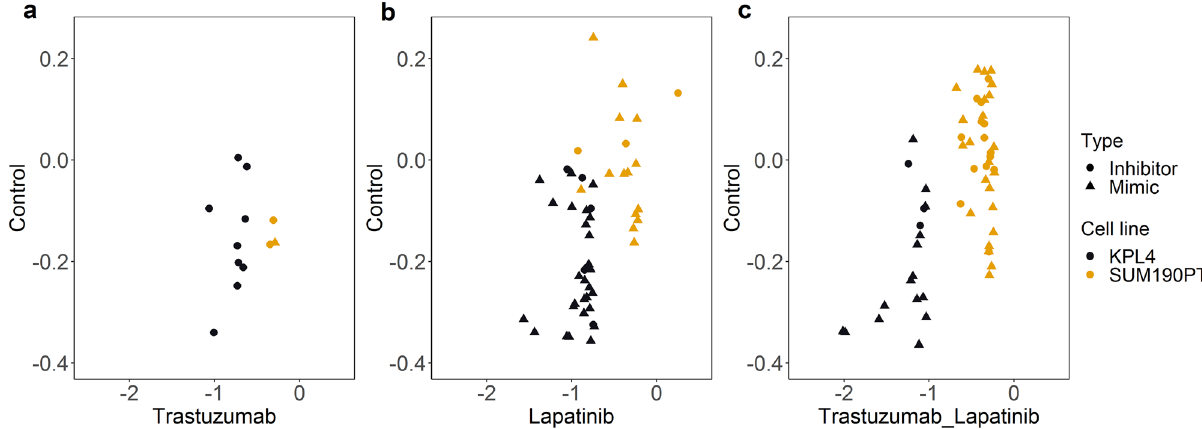
Figure 1. Viability for sensitizing miRNAs in high-throughput screen. The cells were treated with ( a ) Trastuzumab (10 μg/mL), ( b ) Lapatinib (100 nM) or ( c ) Trastuzumab and lapatinib together with a panel of miRNAs, and viability was measured using a CellTiter-Glo assay after 72 h. The scatterplots show viability (loess log) of treated cells (x-axis) vs untreated cells (y-axis) for significant miRNAs. I.e. miRNAs causing a viability reduction greater than three standard deviations from the median of all miRNAs in the same treatment group. Each point represents either a miRNA inhibitor (dot) or a miRNA mimic (triangle). Black color indicates result in KPL4 cells, and orange color indicates result in SUM190PT